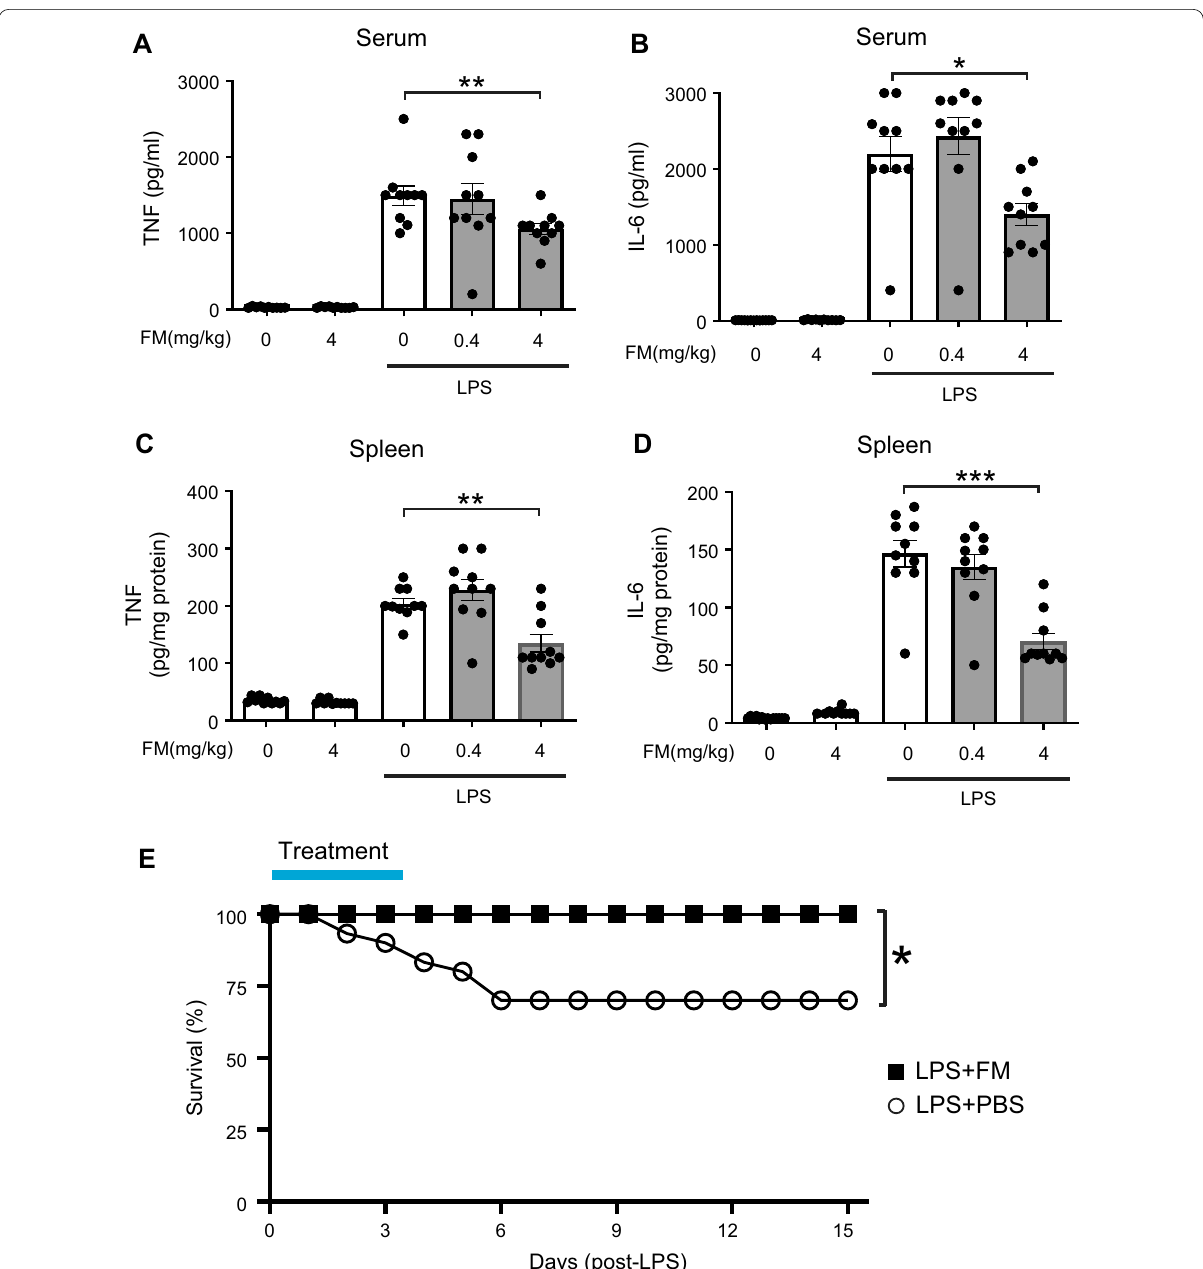
Fig. 1 Famotidine attenuates lipopolysaccharide (LPS)-induced inflammatory responses in mice. A – D Male C57BL/6 mice, 8–12 weeks of age, were injected with LPS (7 mg/kg) with or without famotidine (FM, 0.4 or 4 mg/kg, in 100 µl volume), intraperitoneally (IP) 30 min before LPS injection. Mice were euthanized 2.5 h after LPS administration and serum and spleen TNF and IL-6 were measured. N **P 0.001, ***P < 0.001. E Male C57BL/6 mice, 8–12 weeks old, were injected with LPS (6 mg/kg, IP). Famotidine (FM, 4 mg/kg) or PBS (in 100 µl = volume) were injected intraperitoneally twice a day for 3 days, survival was monitored for 2 weeks. N